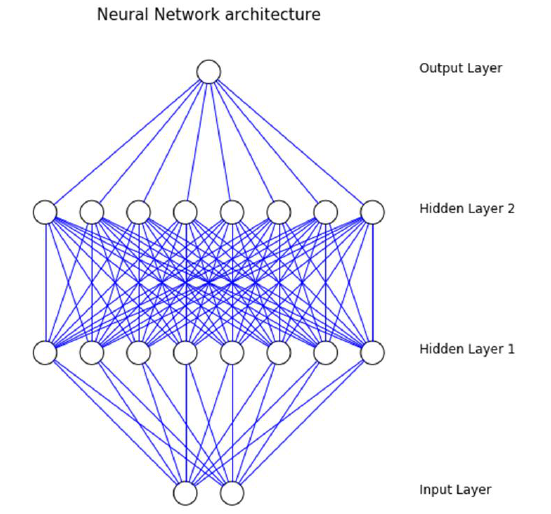
Figure 1. Example of neural network